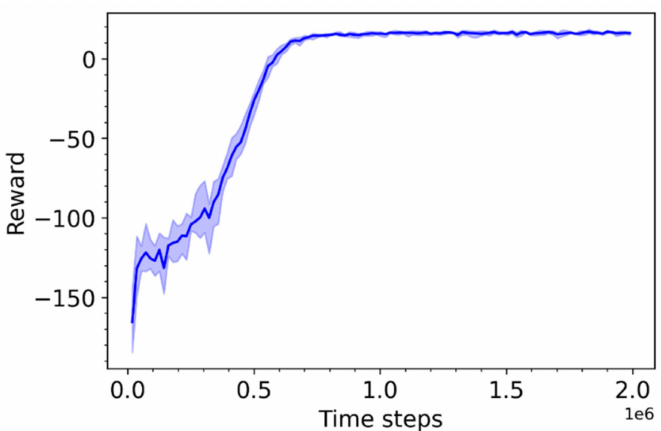
Figure 5. Training progress over six runs with different random seeds for Agent